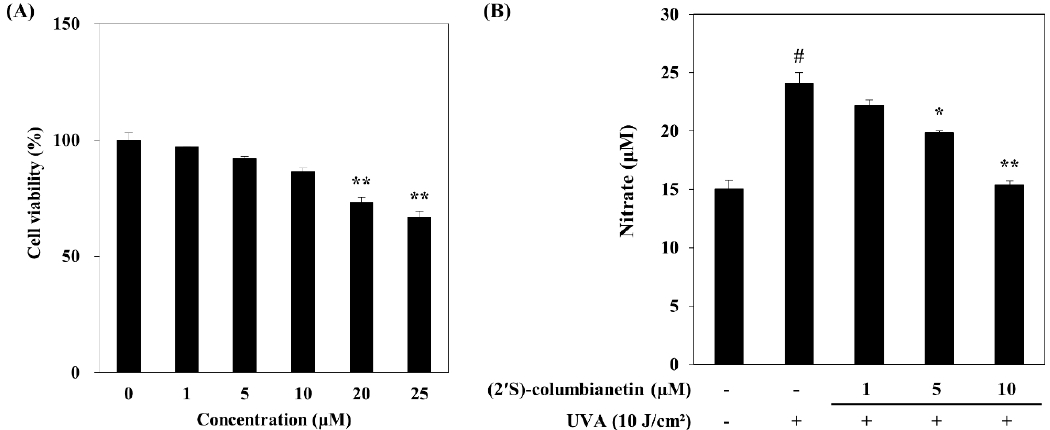
Figure 2. Effect of (2 ′ S)-columbianetin on viability of human dermal fibroblasts (HDFs) and nitrogen species (NO) generation in UVA-irradiated HDFs. ( A ) HDFs were incubated for 48 h following treatment with changing doses of (2 ′ S)-columbianetin. Effects of (2 ′ S)-columbianetin on the viability of HDFs was analyzed by 3-(4,5-dimethylthiazol-2-yl)-2,5-diphenyltetrazolium bromide (MTT) assay. Viability of the cells was calculated from absorbance values and given as the relative percentage of untreated control cells (0 µM). Values are means ± SD ( n = 3). ** p < 0.01 compared to untreated control group (0 µM). ( B ) HDFs were exposed to UVA radiation (10 J/cm 2 ) and treated with given concentrations of (2 ′ S)-columbianetin. After 24 h incubation, nitric oxide generation was quantified as the nitrate amount in the cell culture medium. Values are means ± SD ( n = 3). # p < 0.01 compared to non-irradiated blank group; * p < 0.05, ** p < 0.01 compared to UVA-irradiated untreated control